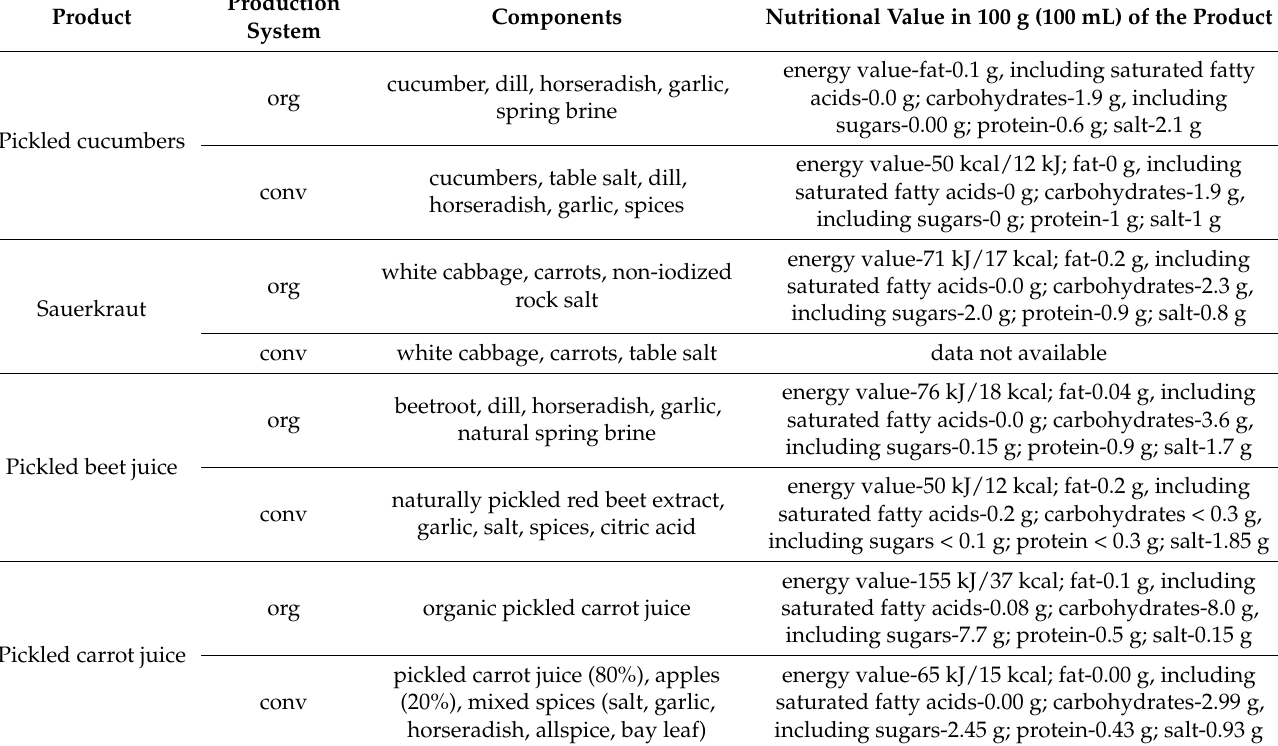
Table 3. Characteristics of fermented food products used in the